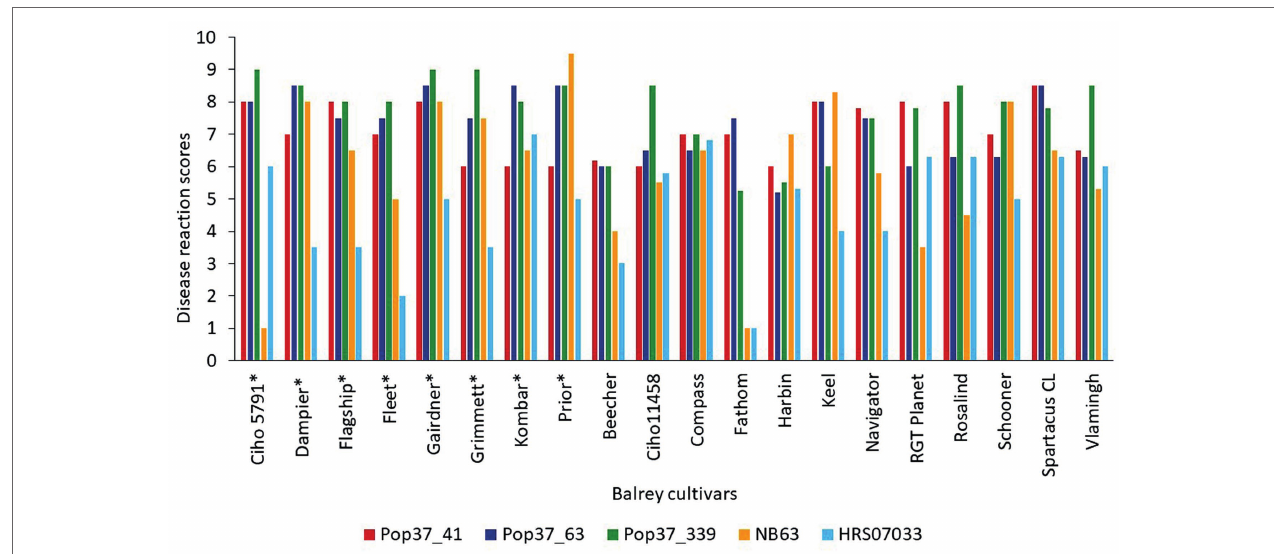
FIGURE 2 | Disease reaction scores of highly virulent progeny isolates ( Pop37 _41, Pop37 _63 and Pop37 _339) and parental isolates (NB63 and HRS07033) of Pop 37 population on all 20 barley cultivars/lines. *Cultivars used for QTL mapping.